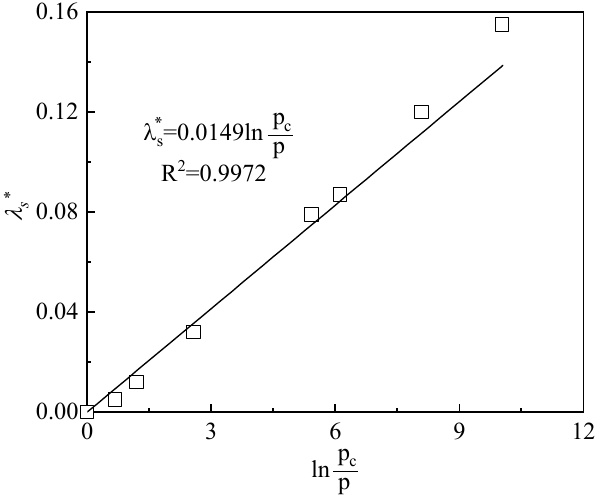
Figure 10. The relationship between the initial swelling index with the over-consolidation ratio ( p / p 0 ).